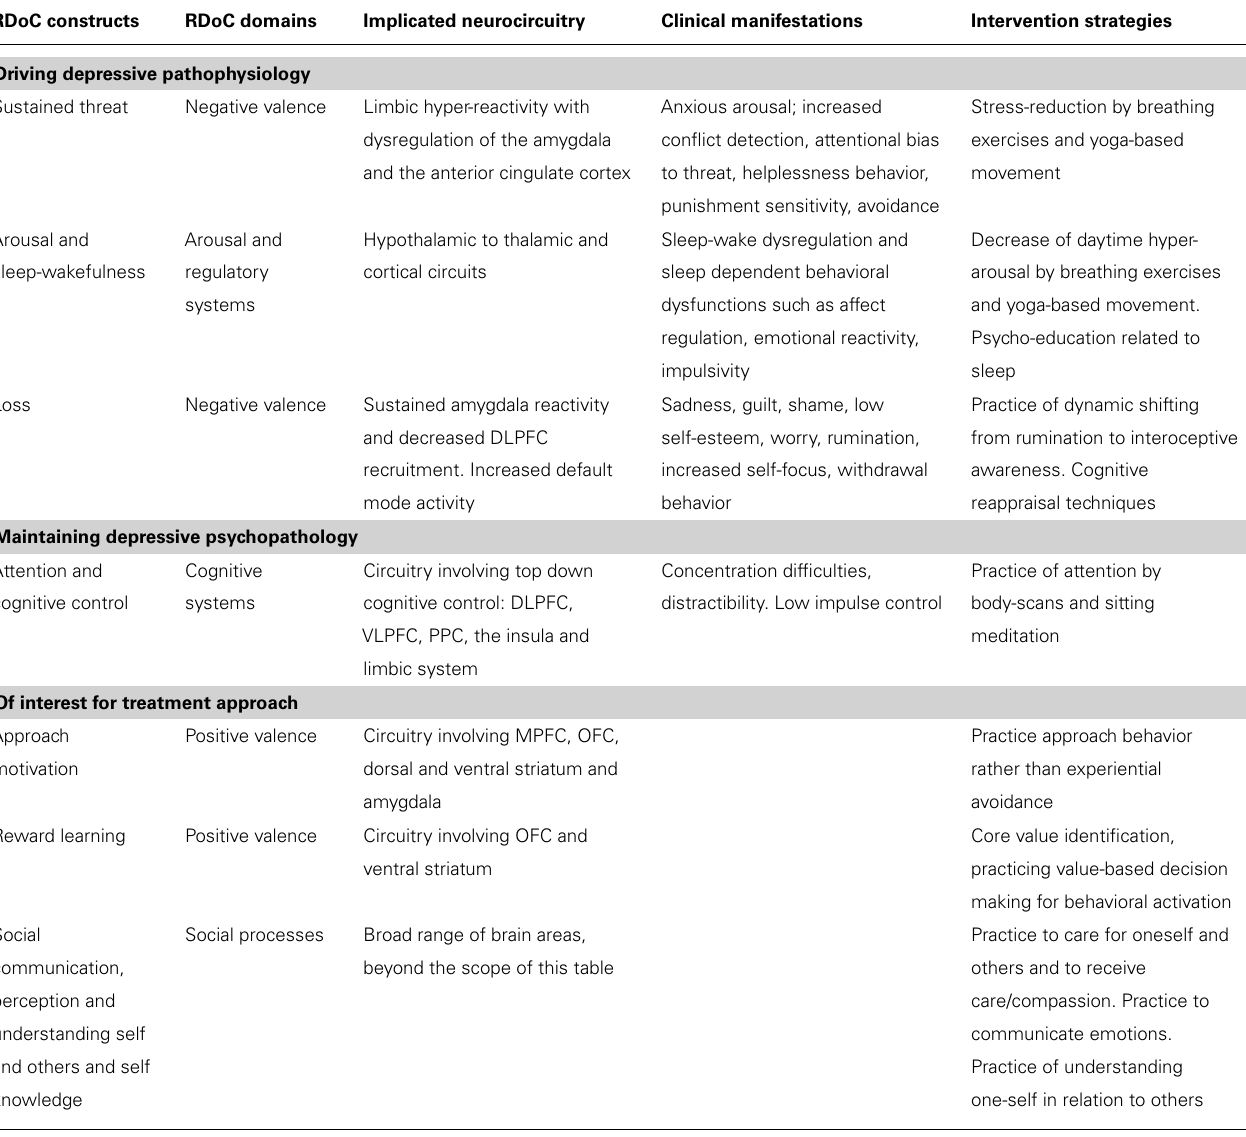
Table 1 |A proposed hierarchy of RDoC constructs relevant in treating mild to moderate adolescent depression without major